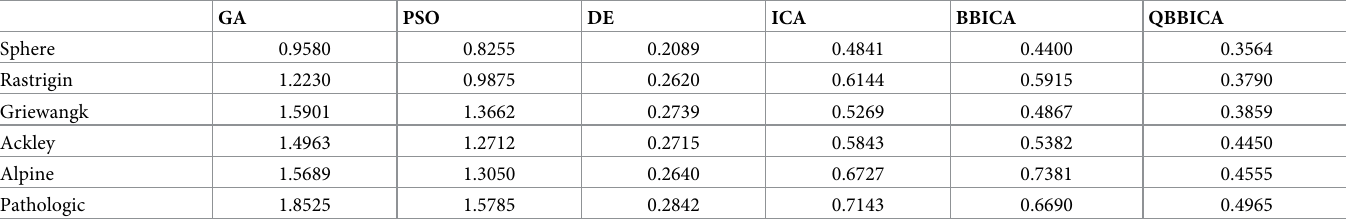
Table 4. Average CPU time (s) of all the referenced algorithm on benchmark function. GA